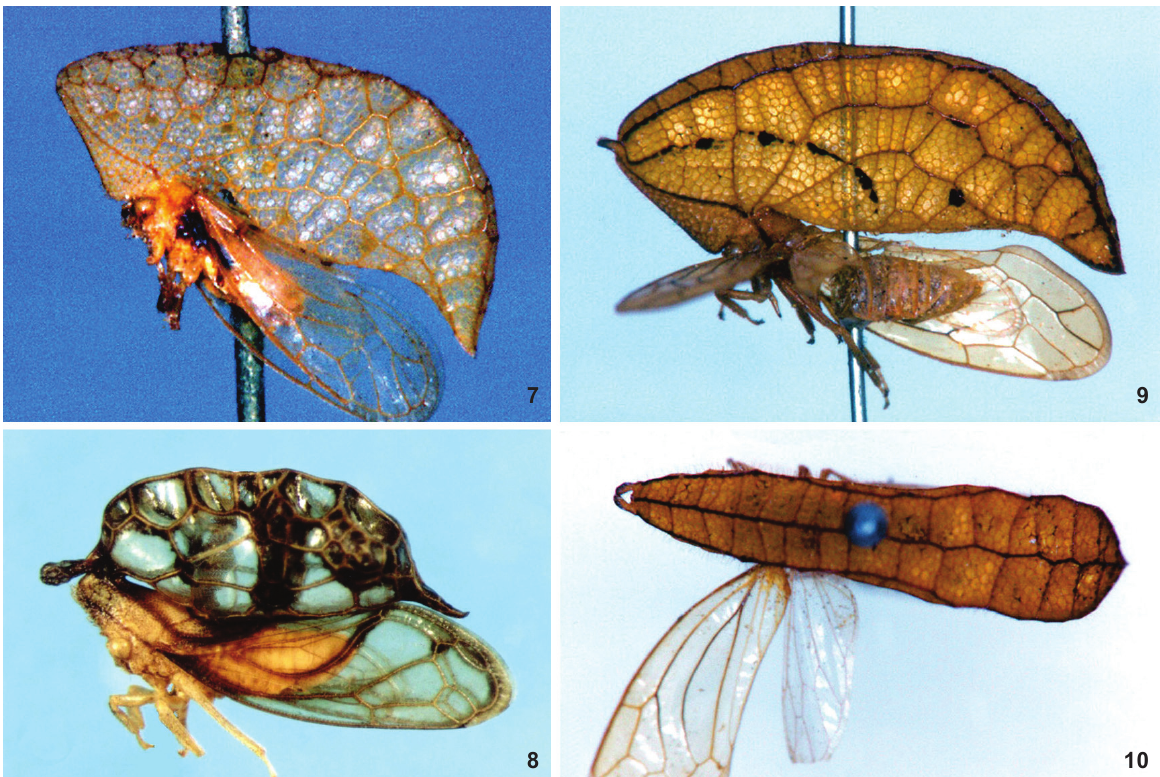
Figs 7-10. Habitus of three species of Oeda : (7) Membracis inflata, holotype female in lateral view; (8) Oeda ( Oedacanthus ) informis in lateral view; (9-10) Oeda hamulata , holotype female in lateral and dorsal